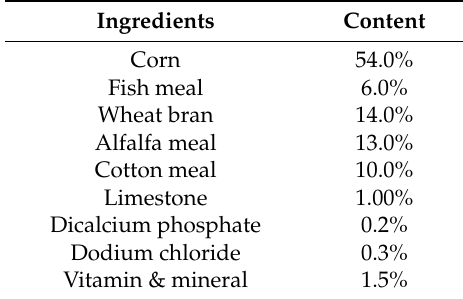
Table 1. Composition of the chow diets.